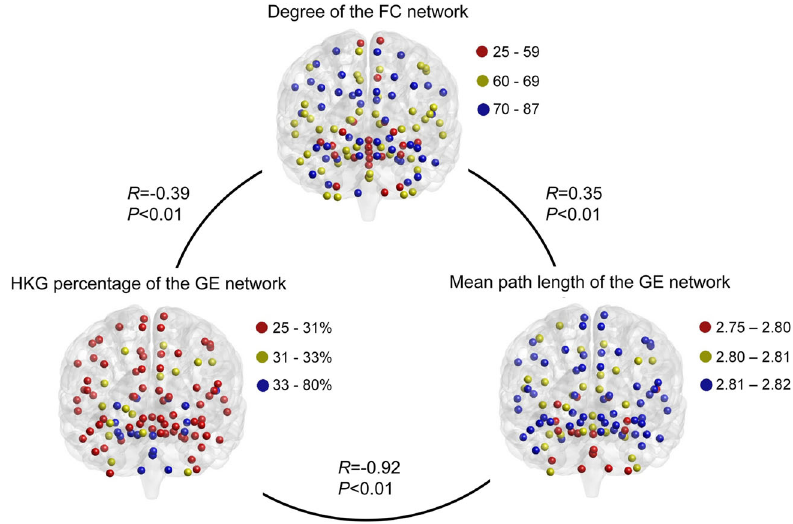
Fig. 4 Comparison of the gene expression networks and the functional connectivity network in human brains. The degree of the functional connectivity network was signi fi cantly negatively correlated with the HKG percentage and positively correlated with the mean path length of the gene expression network in Brain #1. FC functional connectivity, GE gene